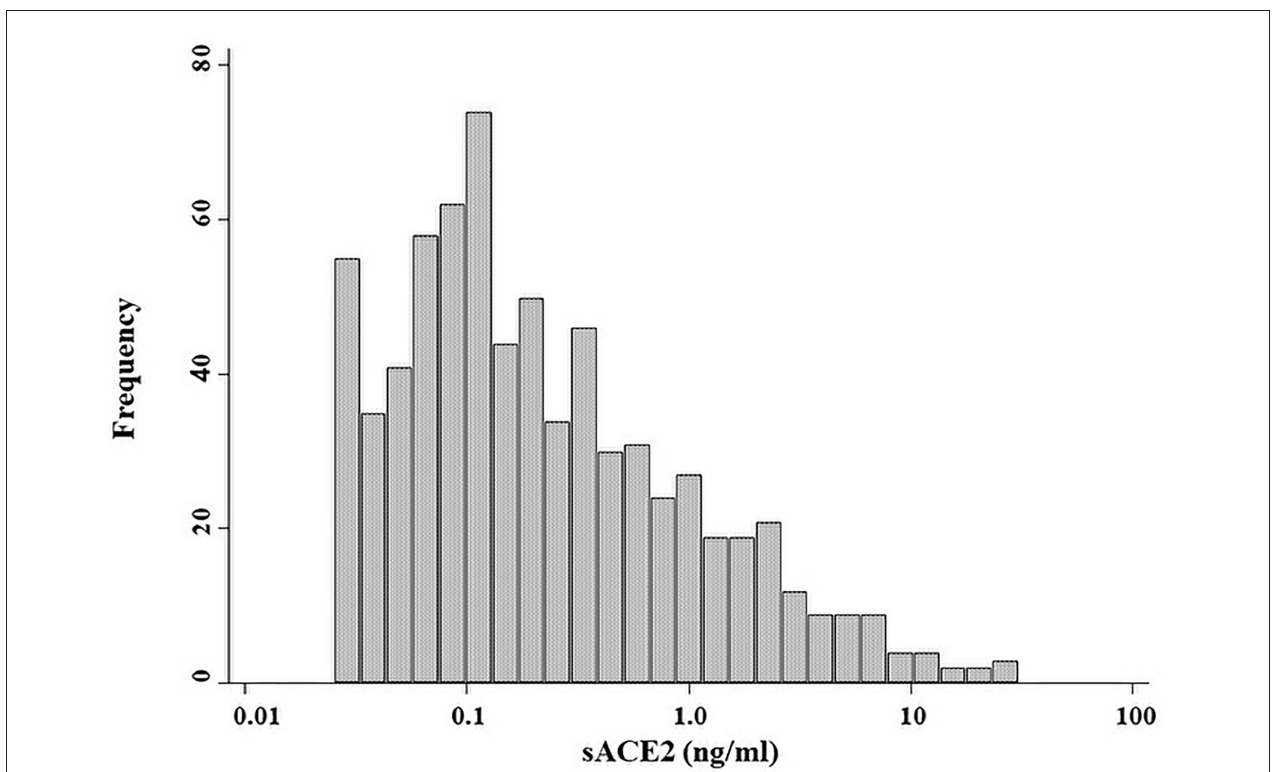
FIGURE 1 | Distribution of serum ACE2 levels. Histogram shows logarithm-transformed levels of serum ACE2 for all patients.